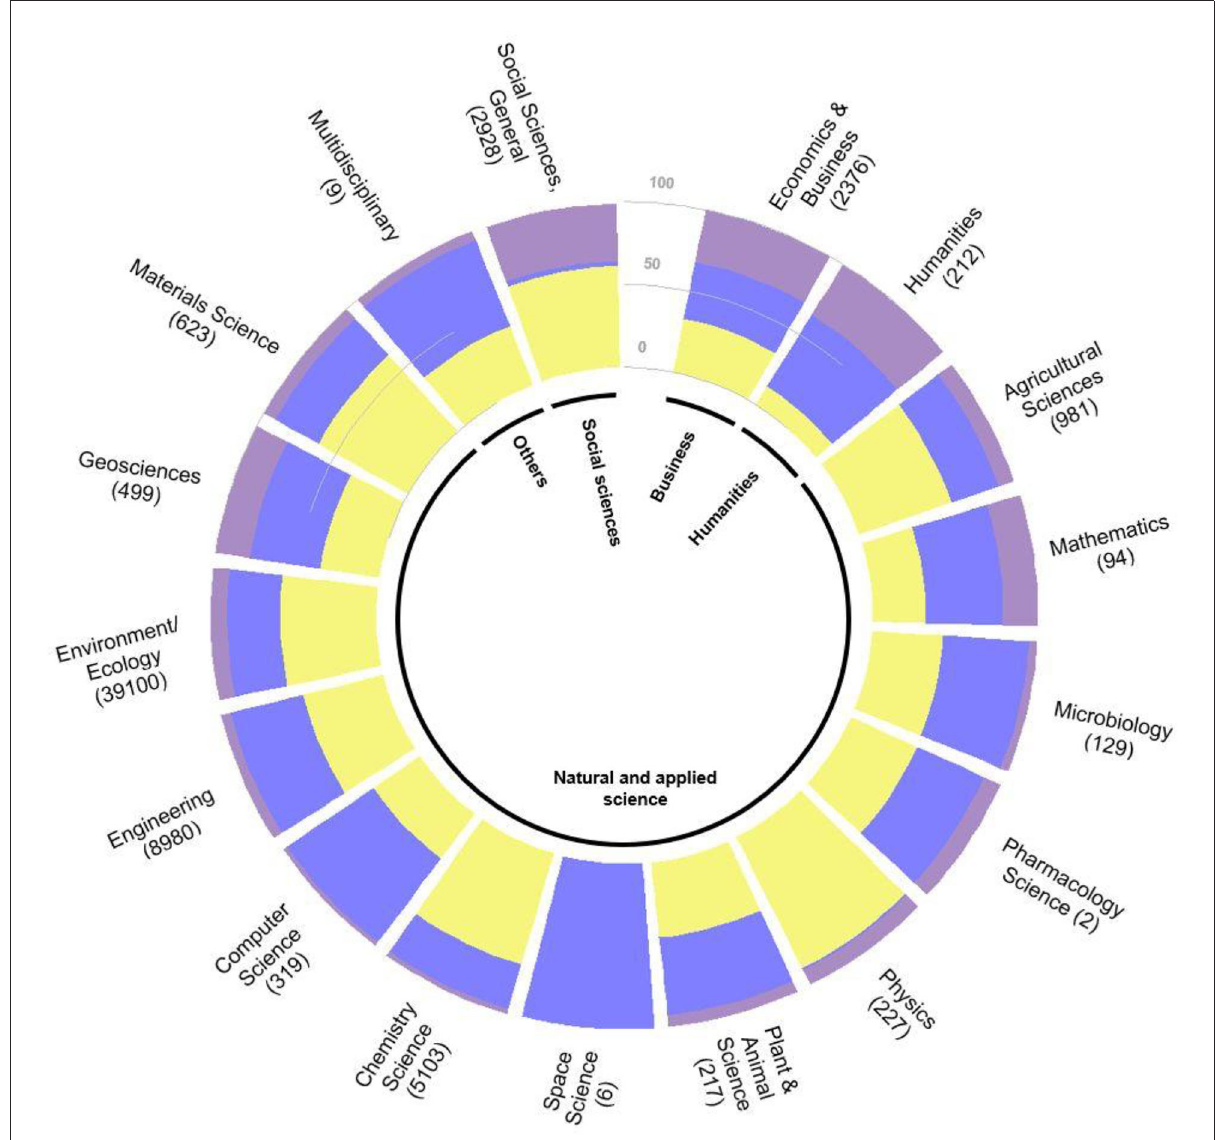
FIGURE4 Circular stacked barplot of the percentage of papers with unique female representation (purple), only male representation (blue), and mixed-gender papers (yellow) by InCites fields. The number of documents is indicated within parentheses. Each paper can be classified into multiple